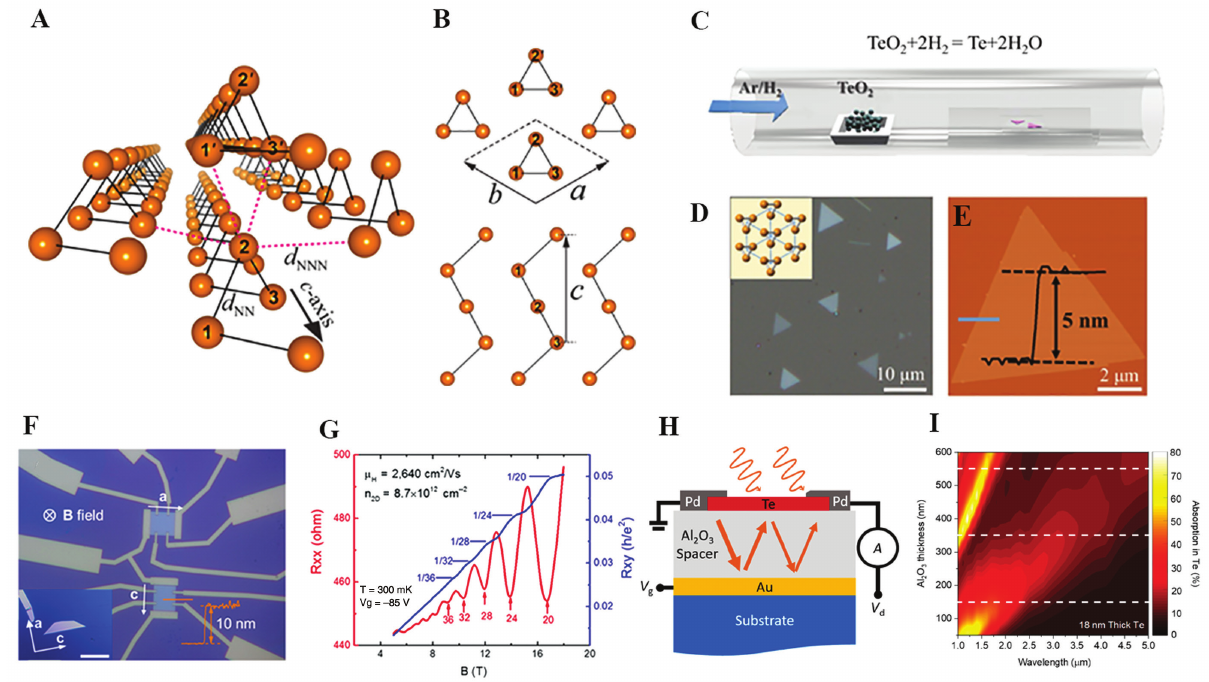
Figure 4: Structure, growth, physics and application of 2D